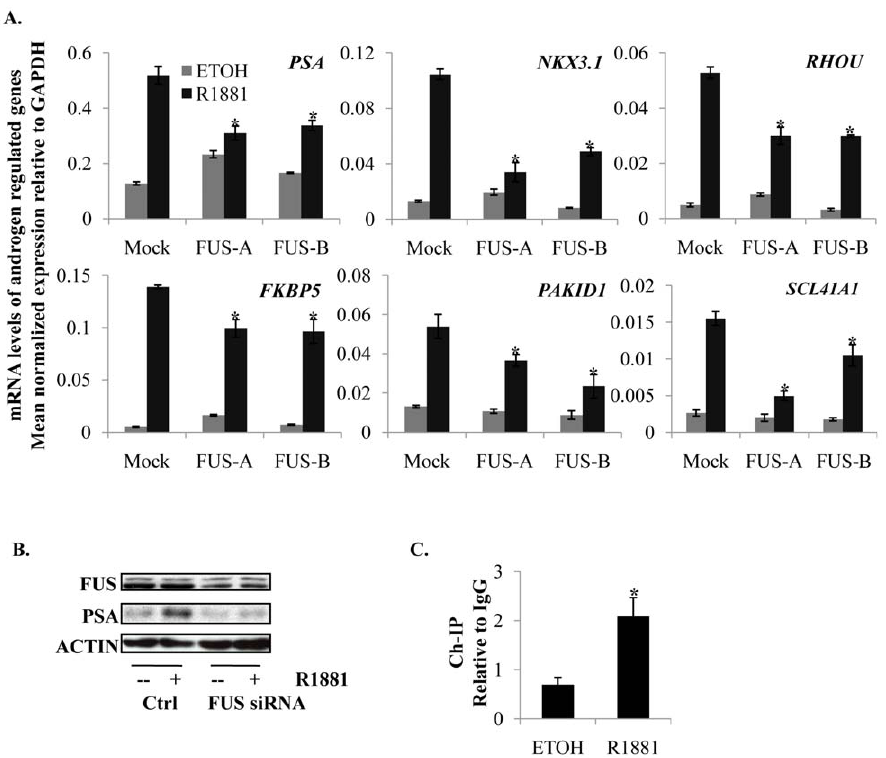
Figure 5. FUS enhances endogenous expression of AR target genes. ( A ) mRNA levels of androgen regulated genes. siRNA mediated depletion of FUS decreases cognate mRNA for PSA and several other AR target genes. qRT-PCR was used to measure mRNA levels. Values represent ratios of GAPDH-normalized signals to those derived from mock-transfected LNCaP cells. Cells were treated for 24 hrs following siRNA transfection. ( B ) PSA protein levels. LNCaP cells were treated for 8 hrs with 10 nM R1881 or vehicle following siRNA transfection and Western blotting was performed to measure PSA levels. ( C ) FUS is recruited to the enhancer ARE III of the PSA gene. LNCaP cells were treated with 10 nM R1881 for 6 hrs. ChIP was subsequently applied and target DNA was amplified by qPCR. Values represent ratio of signals from anti-FUS ChIP to that of IgG isotype control. Columns=mean 6 standard deviation. *P , 0.05, n=3.